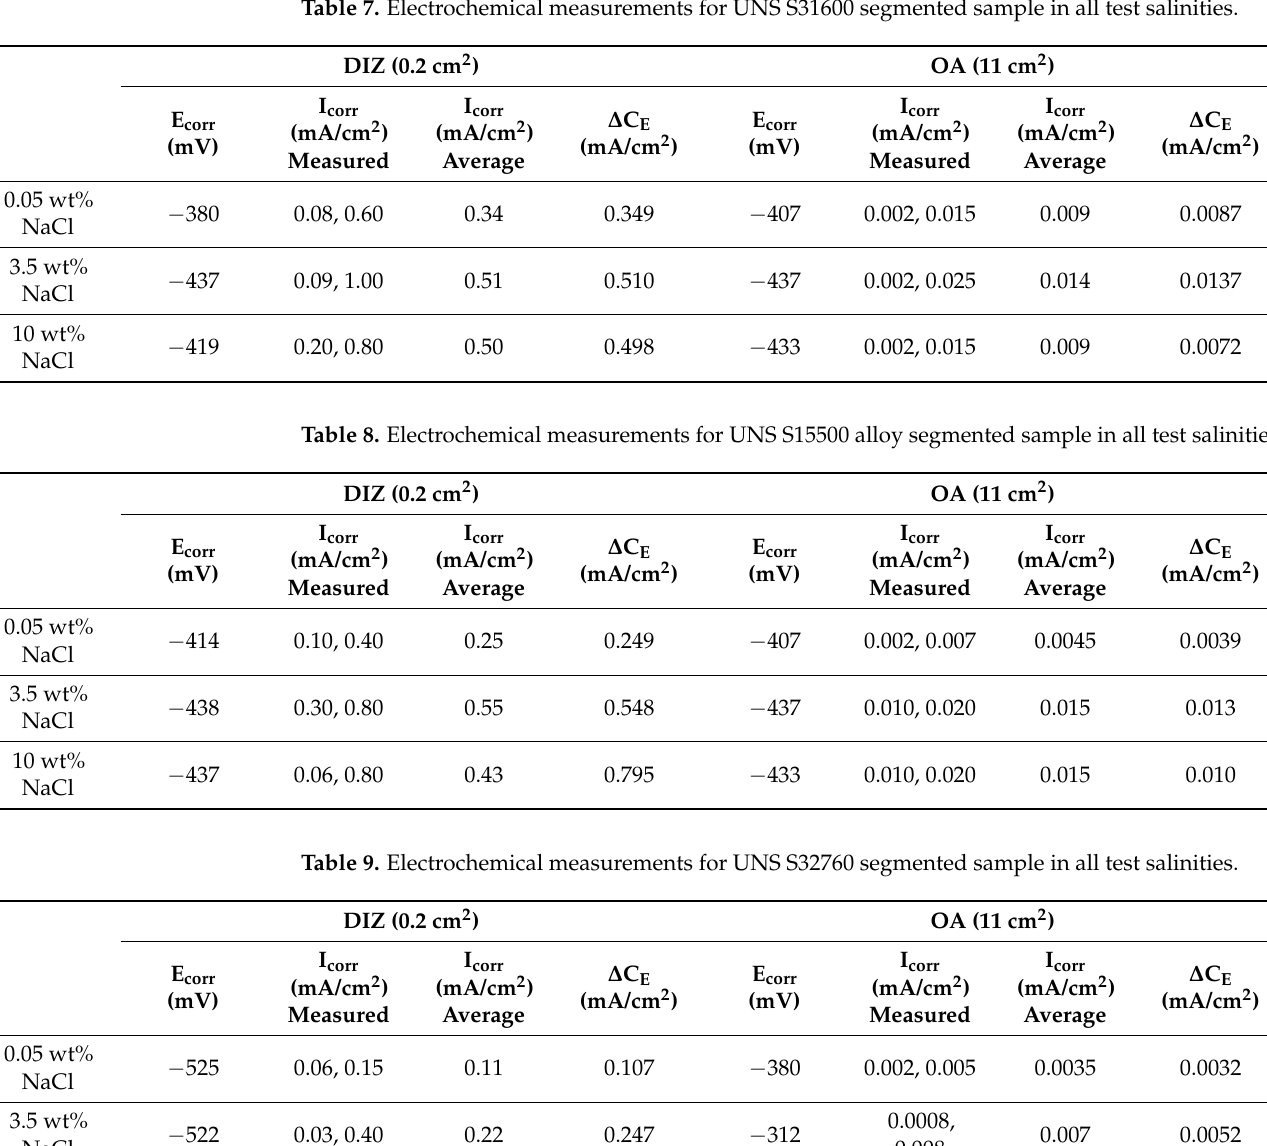
Table 7. Electrochemical measurements for UNS S31600 segmented sample in all test salinities.